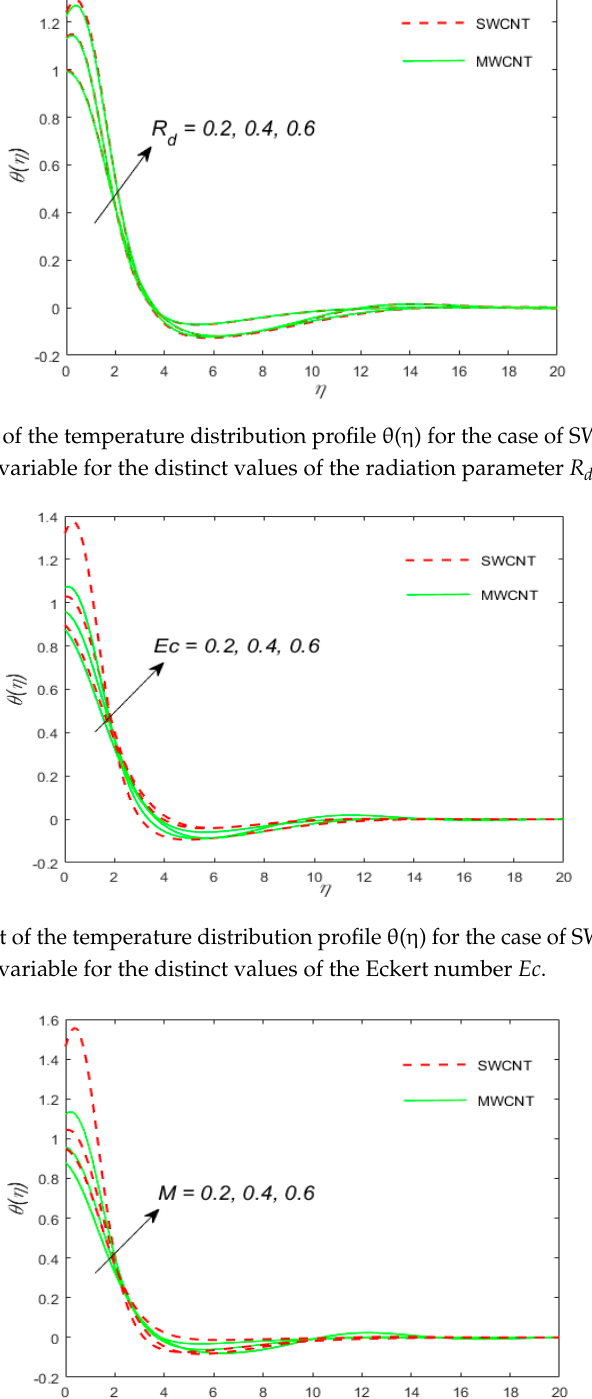
Figure 11. The impact of the temperature distribution profile θ ( η ) for the case of SWCNT and MWCNT versus the similarity variable for the distinct values of the magnetic parameter M .